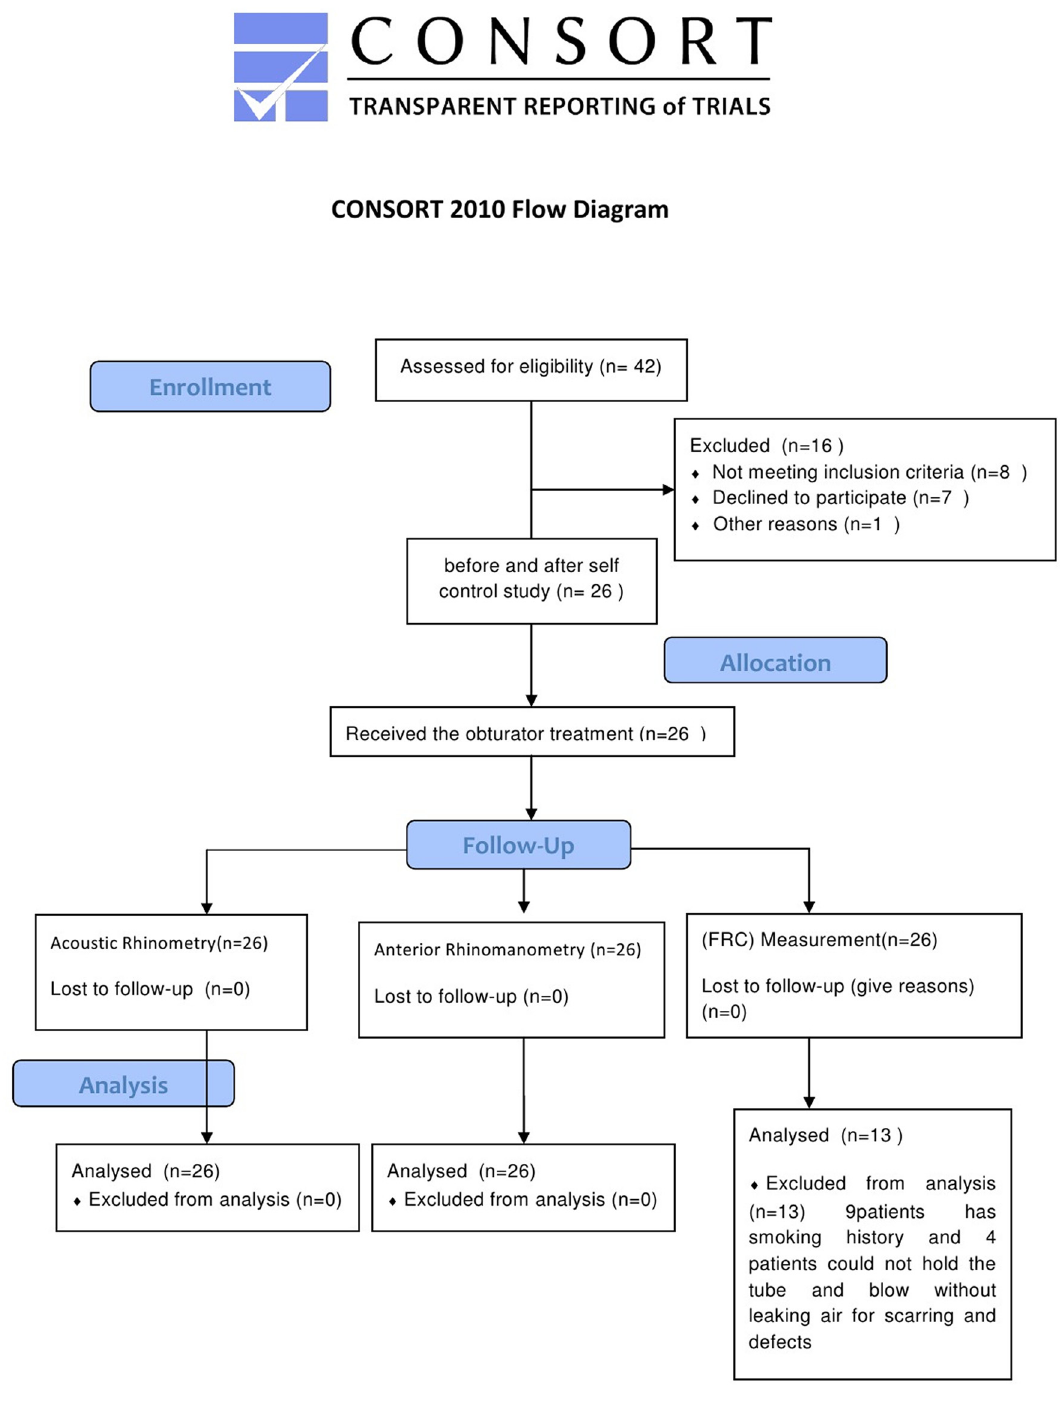
Fig 1. The completed CONSORT